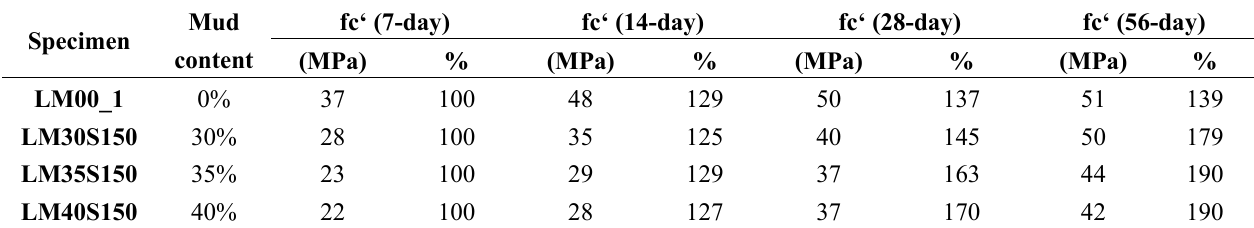
Table 3. Compressive strength development as a function of mud content.